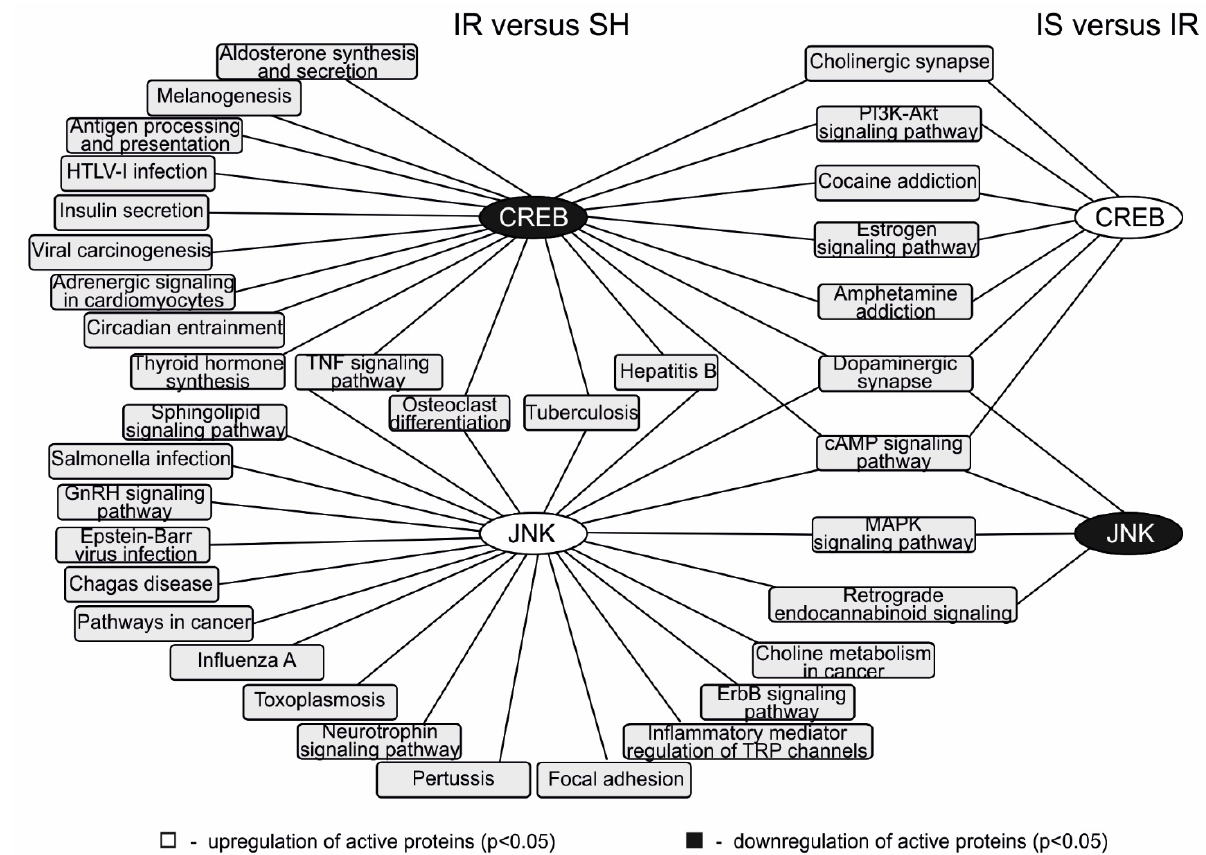
Figure 4. Scheme of JNK and CREB participation in the signaling pathways identified by us previously [17,22] and associated with ischemia–reperfusion and Semax action in the subcortical structures of the brain at 24 h after tMCAO. The network was constructed using the Cytoscape 3.7.0 program. The oval blocks at the nodes represent proteins. The gray rectangular boxes represent signaling pathways. The lines connecting the oval and rectangular blocks indicate the participation of the protein in the signaling pathway.